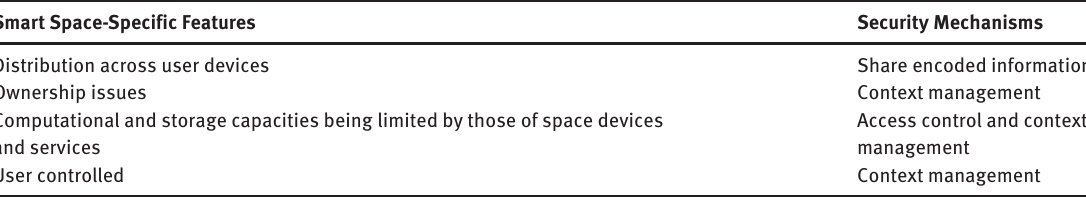
Table 1: Security Mechanisms for Smart Space